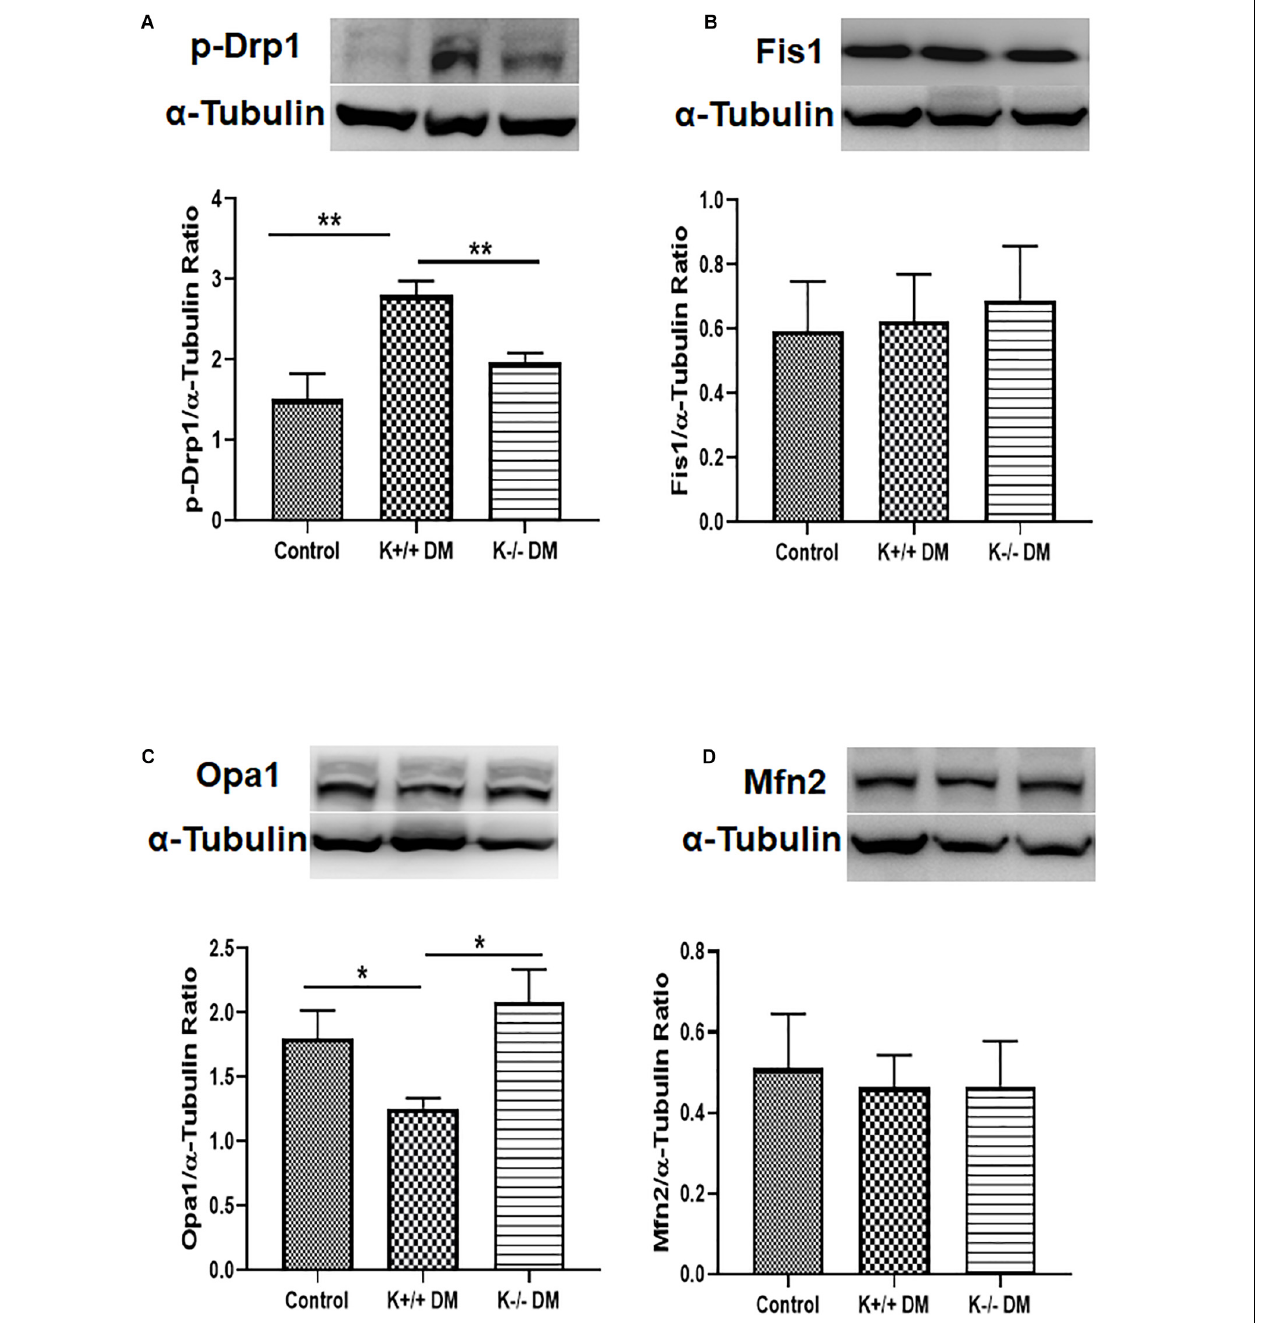
FIGURE 4 | KCa3.1 deficiency attenuated diabetes-induced increased fission and suppressed fusion in diabetic mice. Mitochondrial pro-fission proteins (Drp1 and Fis1) and pro-fusion mediators (Opa1 and Mfn2) were examined by western blotting in kidney tissues. Western blot analysis revealed an increased expression of Drp1 (A) and a reduced expression of Opa1 (C) in diabetic KCa3.1+/+ mice, which were reversed in KCa3.1 deficient mice (K − / − DM). The levels of Fis1 (B) and Mfn2 (D) were not notably changed in mice kidneys. Results are presented as mean ± SEM. * P < 0.05, ** P < 0.01, N = 5.